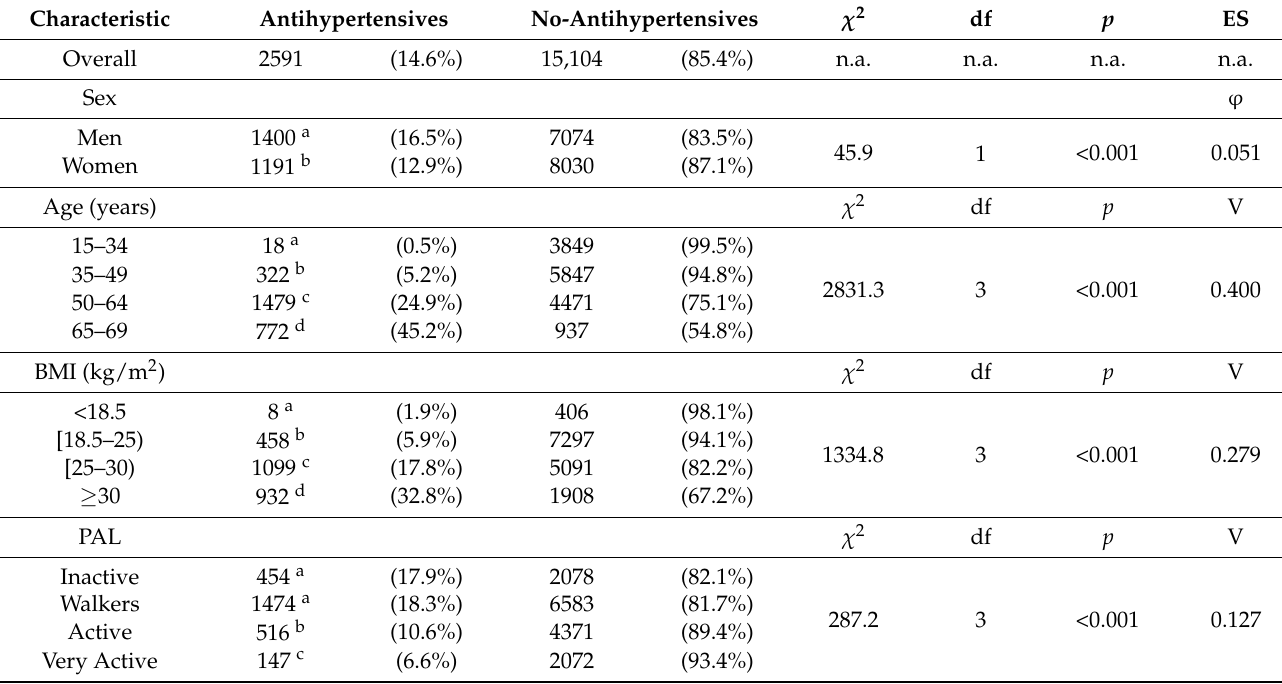
Table 3. Population characteristics, according to the use of antihypertensives in Spanish 15–69-year- olds in SNHS2017.